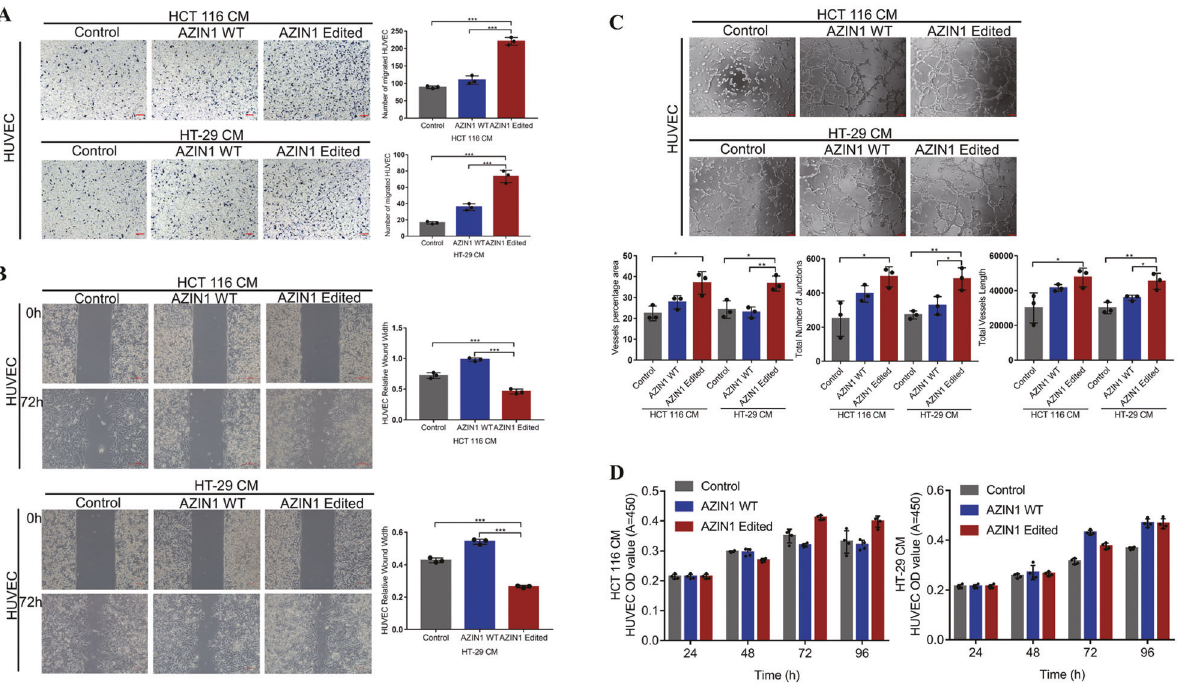
Fig. 2 Functional effects of CM from colorectal cancer cells overexpressing edited AZIN1 on HUVEC. A Migration of HUVEC by treatment of CM from HCT 116 and HT-29 overexpressing edited AZIN1. Scale bars, 100 μ m. B Wound healing of HUVEC. Scale bars, 200 μ m. C Tube formation of HUVEC. Scale bars, 75 μ m. D The proliferation of HUVEC tested by CCK-8. Data are presented as means ± SD; n = 3; One-way ANOVA with Tukey ’ s test as post-hoc test was used to assess the difference; * P < 0.05, ** P < 0.01, *** P <